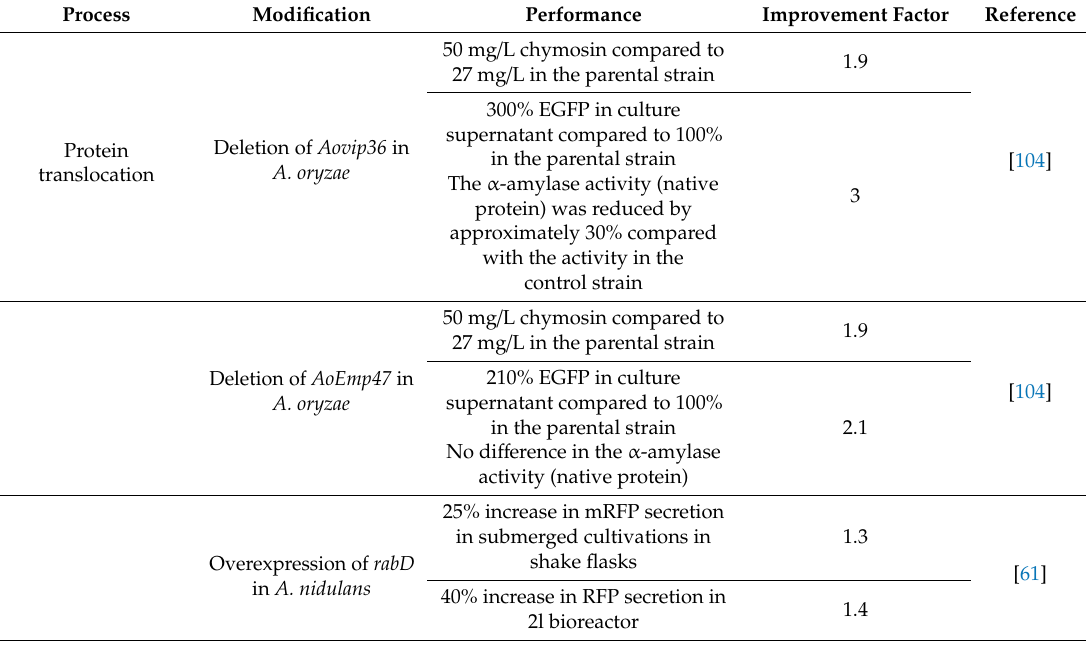
Table 7. Projects for improving recombinant protein production through engineering protein tra ffi